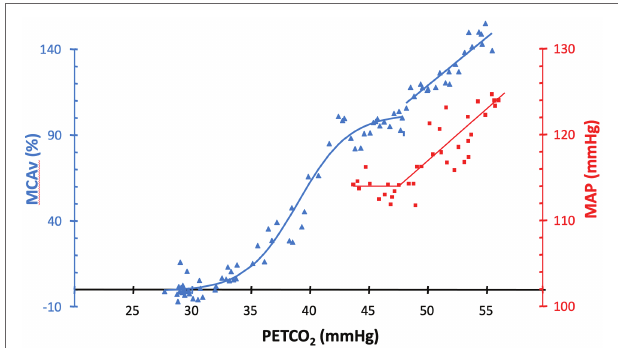
FIGURE 5 | MAP (squares) and %MCAv (triangles) responses to increases in P ET CO 2 in a healthy subject. In the presence of hypercapnia, an apparent “autoregulatory break-through” occurs in this subject at approximately 47 mmHg. Figure recreated and modified from Battisti-Charbonney et al.